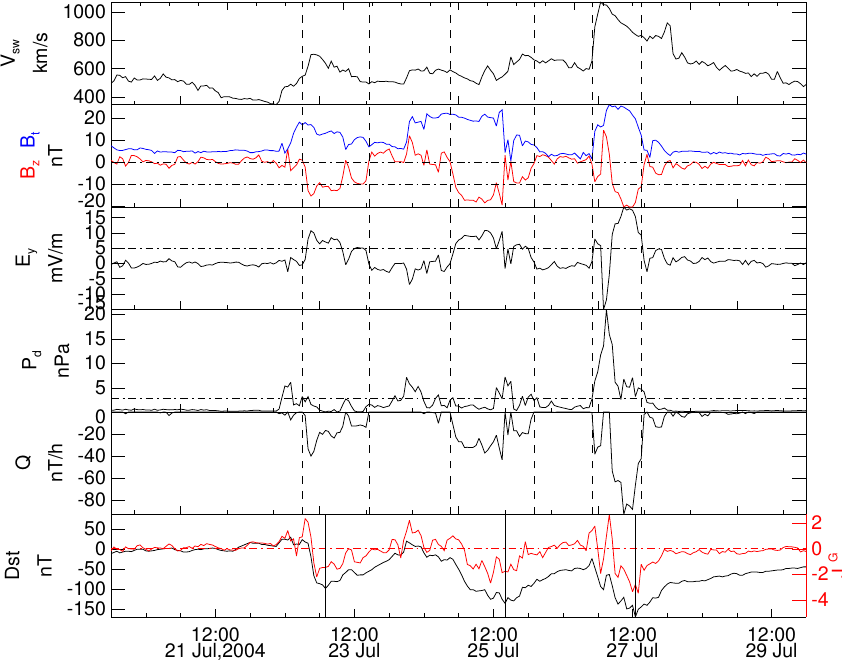
Figure 6. The great magnetic storm events on 23–27 July 2004. The panels are similar to Figure 4. The vertical lines in the top 5 panels are 02:00 15 May, 06:00 15 May, and 08:00 15 May, respectively. The vertical lines in the bottom panel are 02:00 15 May, and 08:00 15 May,